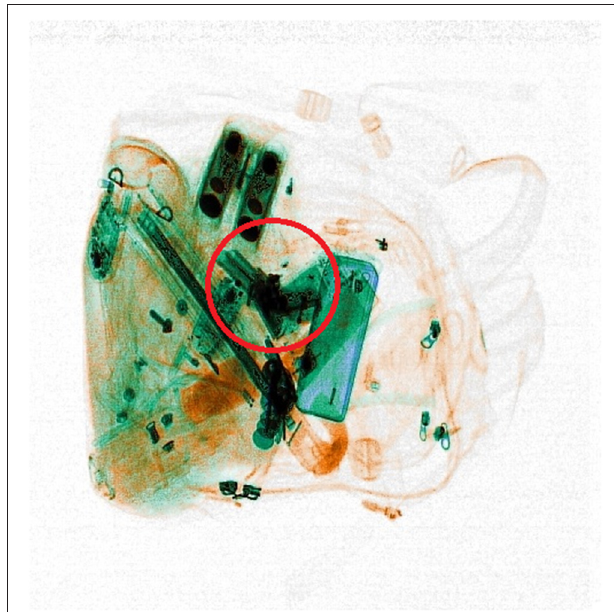
FIGURE 1 | Example of the x-ray images used in the x-ray screening task. The red circle locates the threat for demonstrative purposes. It was shown in the feedback displays of the practice trials but did not appear in the